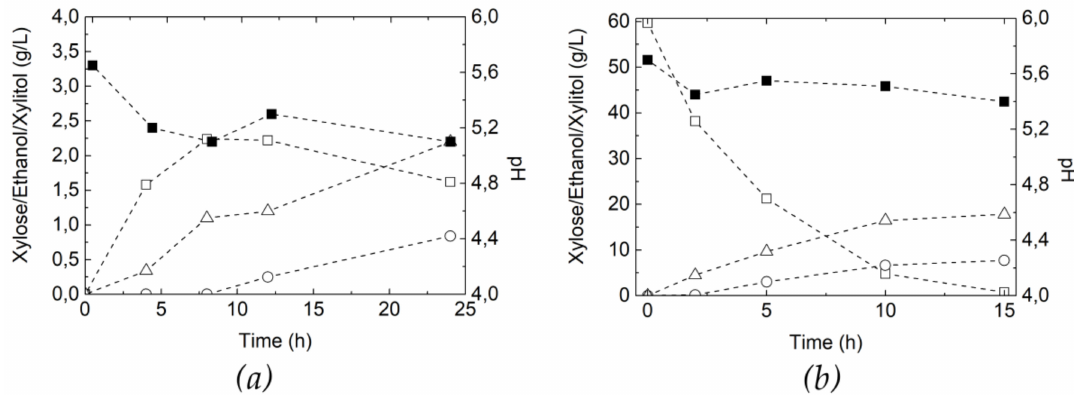
Figure 2. ( a ) SHIF of pre-hydrolyzed birchwood xylan using a biocatalyst containing 5 w % of Accellerase XY, 15 w % of XI, and 10 w % dry mass yeast (1.7 × 10 4 IU/L, 3.7 × 10 4 IU/L, and 50 g/L, respectively), pH 5.6, 150 rpm stirring, and 32 ◦ C; ( b ) control experiment using xylose as substrate (SIF): pH ( (cid:4) ), xylose ( (cid:3) ), ethanol ( ∆ ), and xylitol